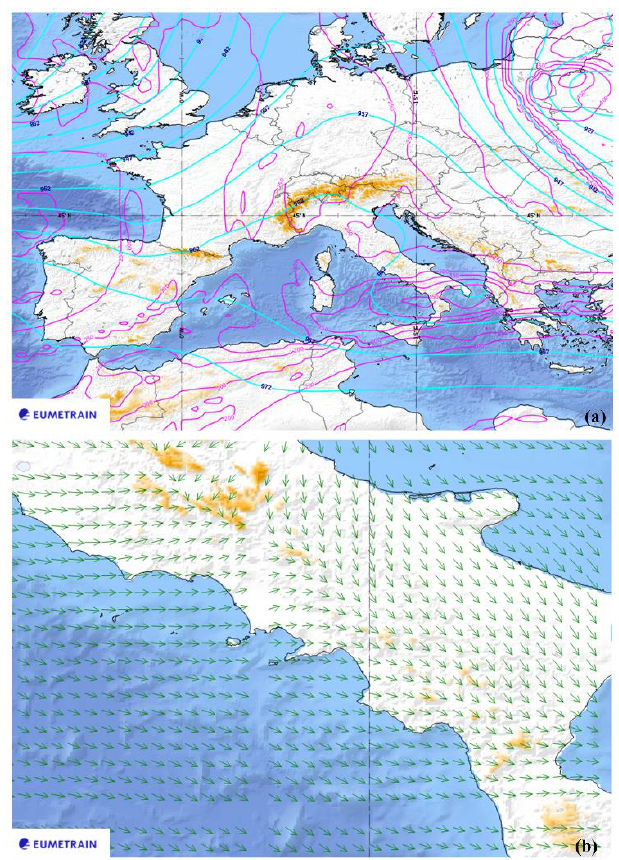
Figure 10. In the upper panel ( a ), the 300 hPa geopotential height ( Z300 ) and the height of 1.5 Potential Vorticity ( PV ) fields on 1 August 2020, 12:00 UTC are presented. The Z300 (in dam) is shown as a cyan contour with an interval of 5 dam, whereas the height of 1.5 PV (in hPa) is sketched as a magenta contour every 100 hPa. In the bottom panel ( b ), for the same event, the surface winds, shown as green arrows, are shown. All fields are numerical model outputs and they have been retrieved from the European Centre for Medium Range Weather Forecast (ECMWF) archive, available through the EUMeTrain ePort Pro website [67].